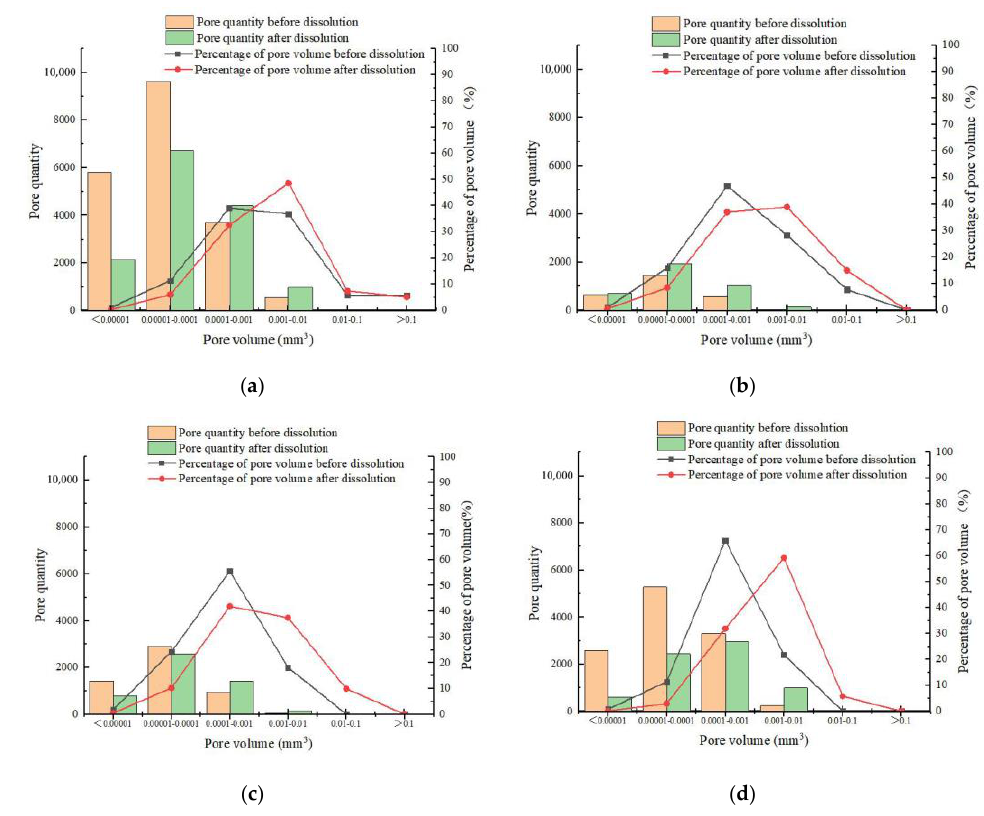
Figure 9. Relationship between pore quantity and the corresponding volume percentage for differ- ent pore volumes: ( a ) sample 5#, ( b ) sample 6#, ( c ) sample 7#, and ( d ) sample 8#.